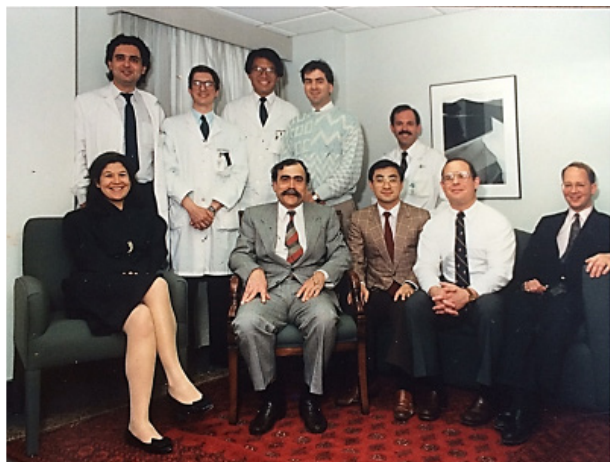
Fig. 9 - Tomas Salerno with graduating fellows from the University of Toronto in the 1980’s.